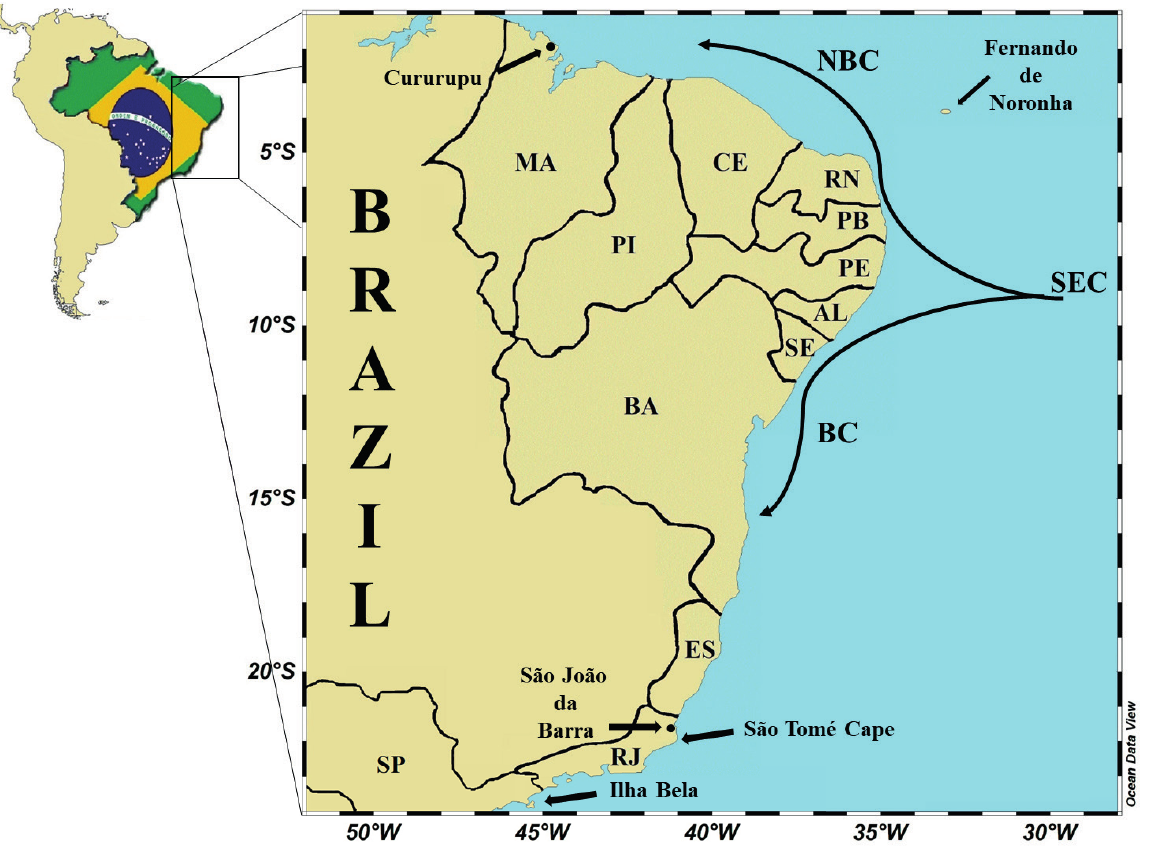
Figure 1. Affected area along the Brazilian coast. Legend: SEC – southern branch of the South Equatorial Current; NBC – North Brazil Current; BC – Brazil Current; MA – Maranhão; PI – Piauí; CE – Ceará; RN – Rio Grande do Norte; PB – Paraíba; PE – Pernambuco; AL – Alagoas; SE – Sergipe; BA – Bahia; ES – Espírito Santo; RJ – Rio de Janeiro; SP – São